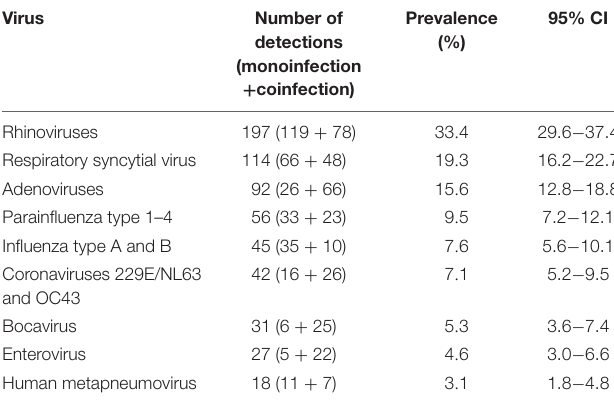
TABLE 1 | Prevalence of respiratory viruses detected by multiplex PCR in the study population. Virus